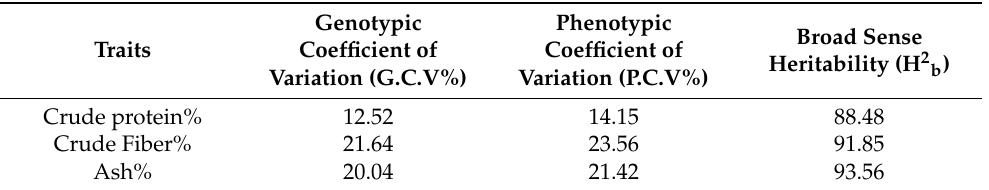
Table 7. The percentage of variability parameters for quality of studied traits in twenty-one alfalfa genotypes in the first year.